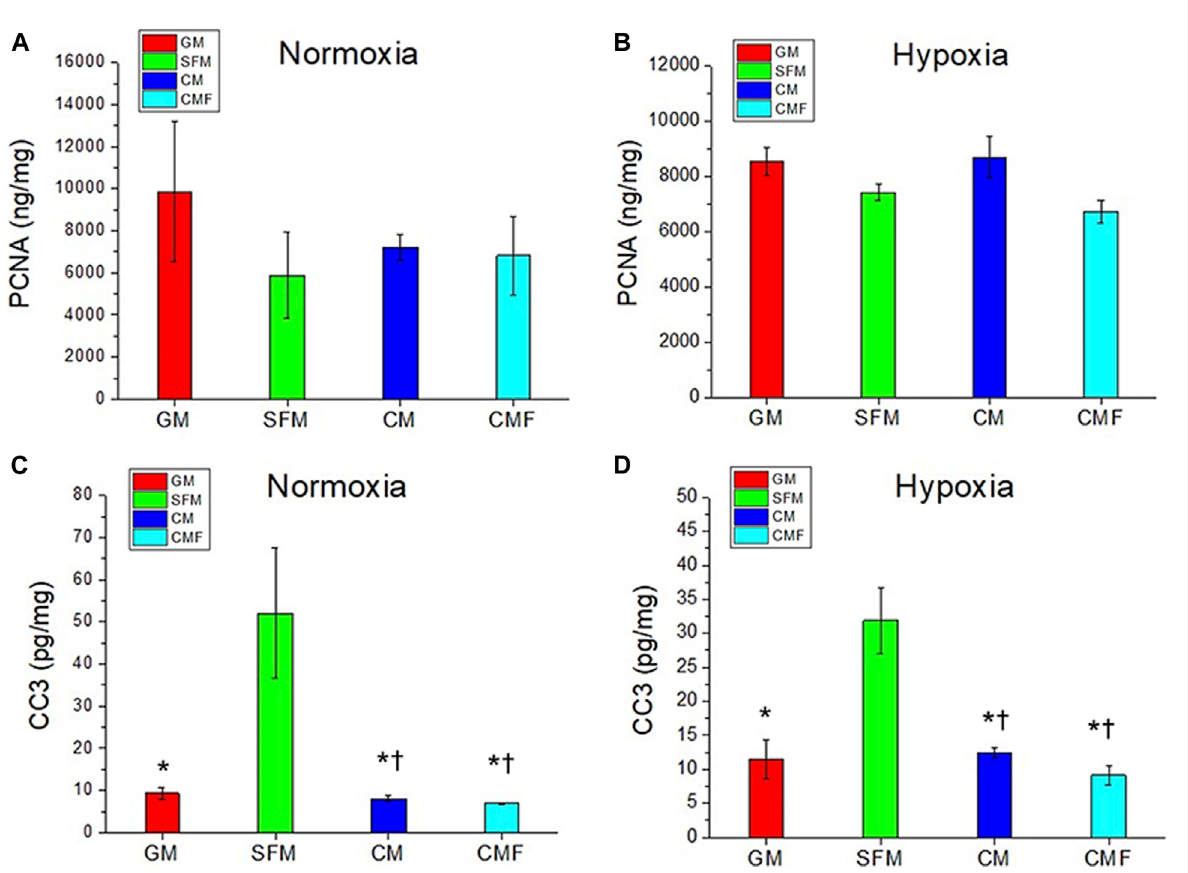
FIGURE 5 HDF proliferation and anti-apoptosis effect of CMF treatment. HDF is treated with GM, SFM, CM (6×), and CMF (6×) for 3 days, and pro- proliferative and anti-apoptotic effect is investigated using Proliferating cell nuclear antigen (PCNA) and Cleaved caspase-3 (CC3) ELISA assay. (A,B) PCNA (ng/mg) in normoxia (A) and hypoxia (B) . (C,D) CC3 (pg/mg) in normoxia (C) and hypoxia (D) . PCNA protein levels show no signi fi cant difference betweenGM, SFM, CM, and CMF. CMF and CM prevent HDF apoptosis but do not improve proliferation signi fi cantly ( n = 3, one-way ANOVA and Tukey ’ s test, * p < 0.05 with SFM, † p > 0.05 with